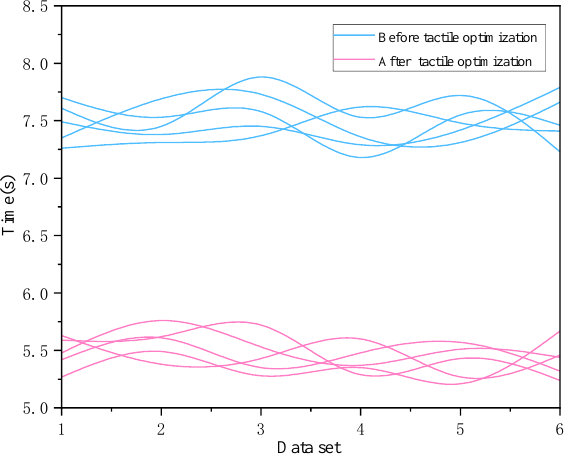
Figure 20. Comparison chart of comprehensive experiment time. Analysis of variance was performed on the time data before and after the above op- timization, the reaction time of the experimental group with a tactile cue ( M = 5.45, SD = 0.15) was significantly lower than that of the experimental group without a tactile cue ( M = 7.49, SD = 0.18), t (29) = 54.88, p = 0.000 < 0.05, d = 10.02, This effect data is large.